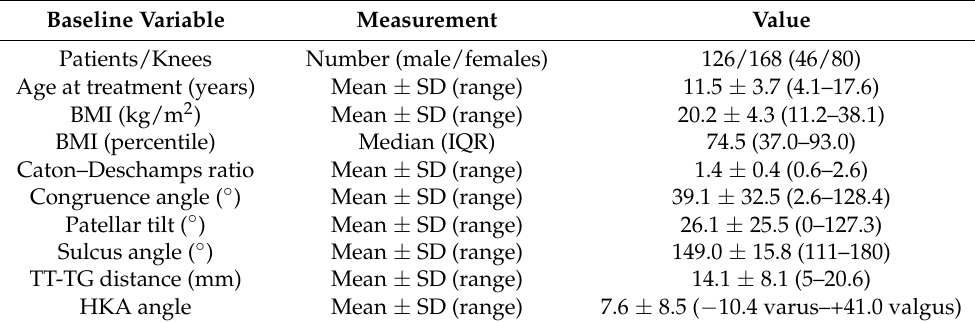
Table 2. Demographic and radiographic baseline data.